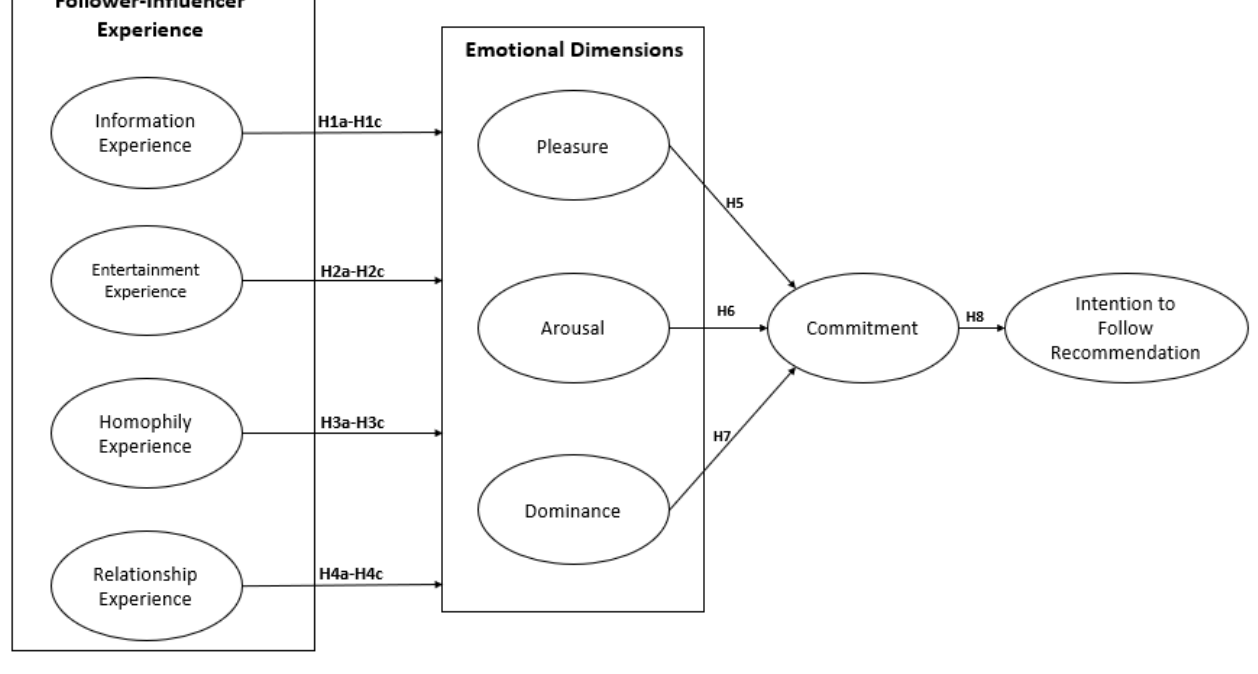
Figure 1. Research